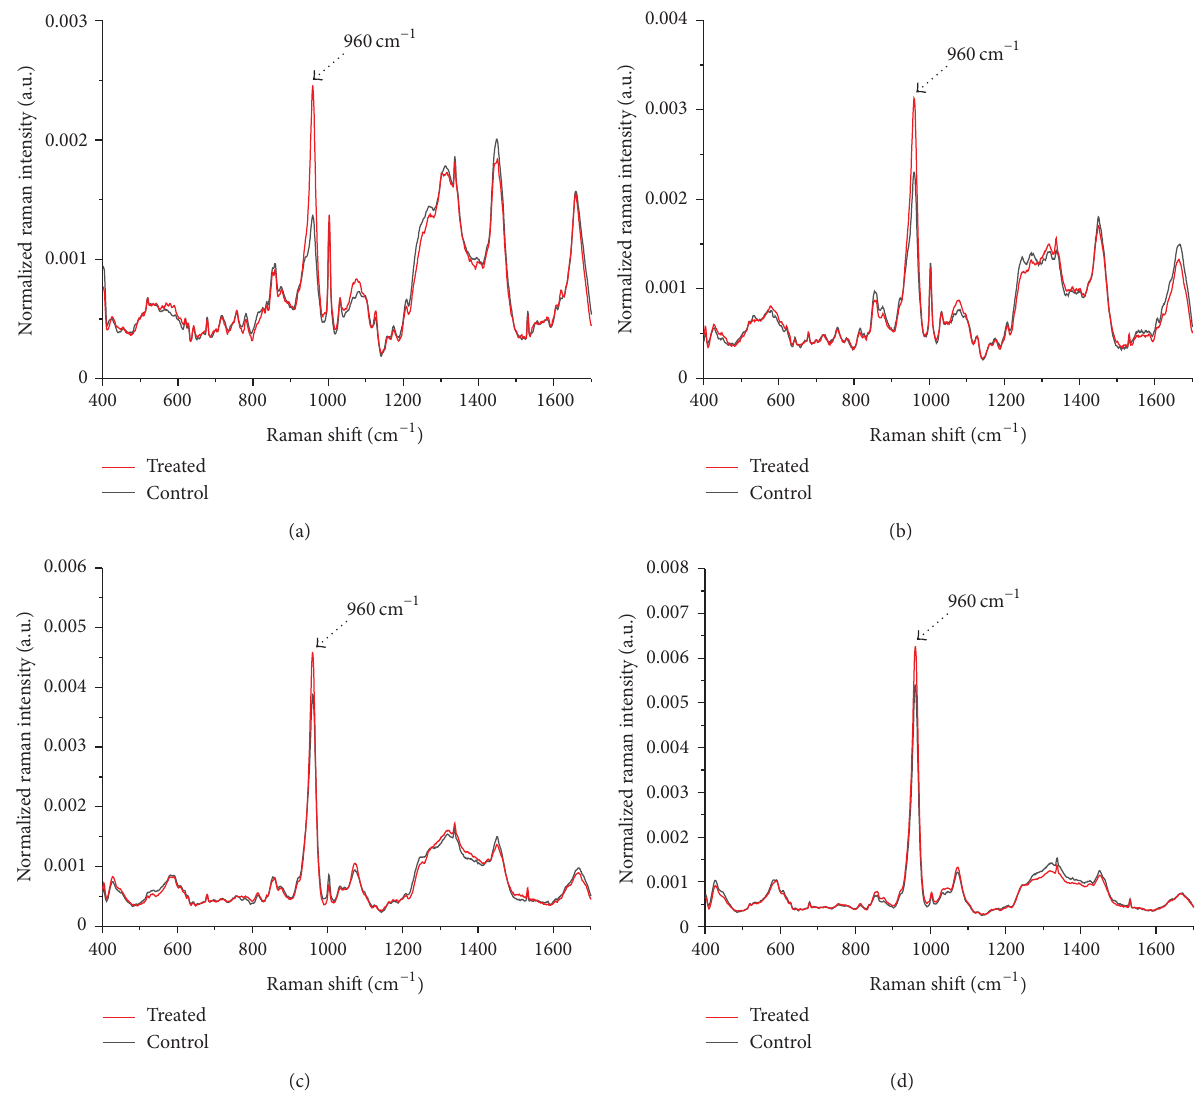
F 2: Mean normalized Raman spectra of the bones from control group and treated groups measured at (a) 7 days, (b) 15 days, (c) 23 days, and (d) 30 days aer